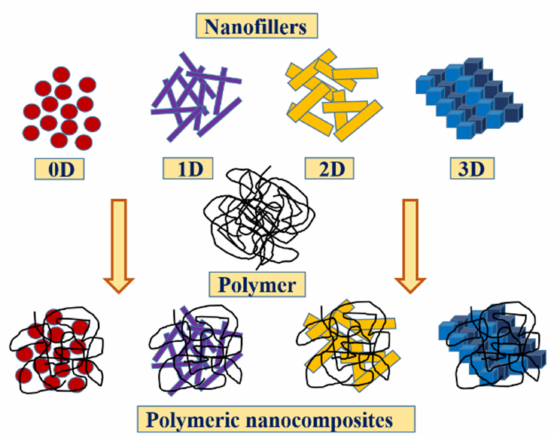
Figure 1. Classification of nanomaterials based on their dimensionality: zero- (0D), one- (1D), two- (2D), and three-dimensional (3D)